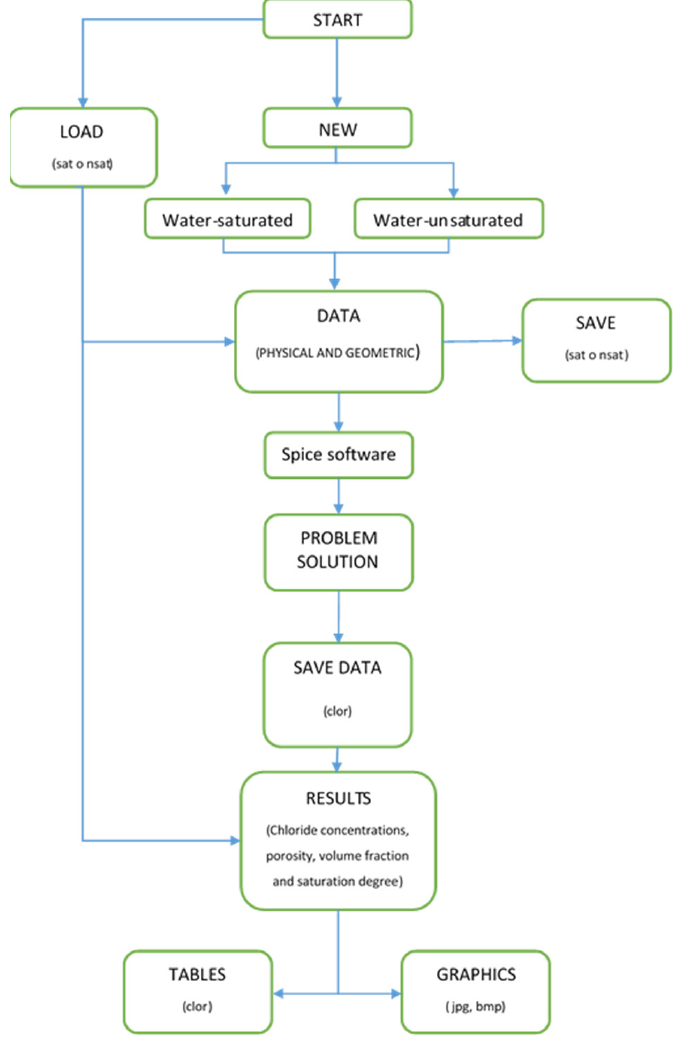
Figure 4. Flow diagram of Concrelife software.